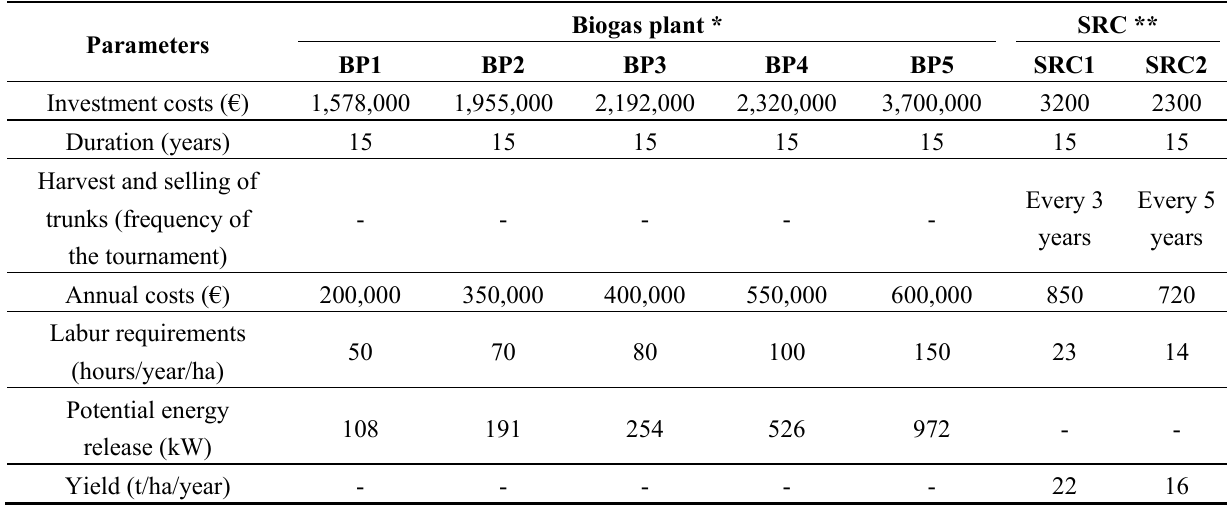
Table 1. Main parameters used in the